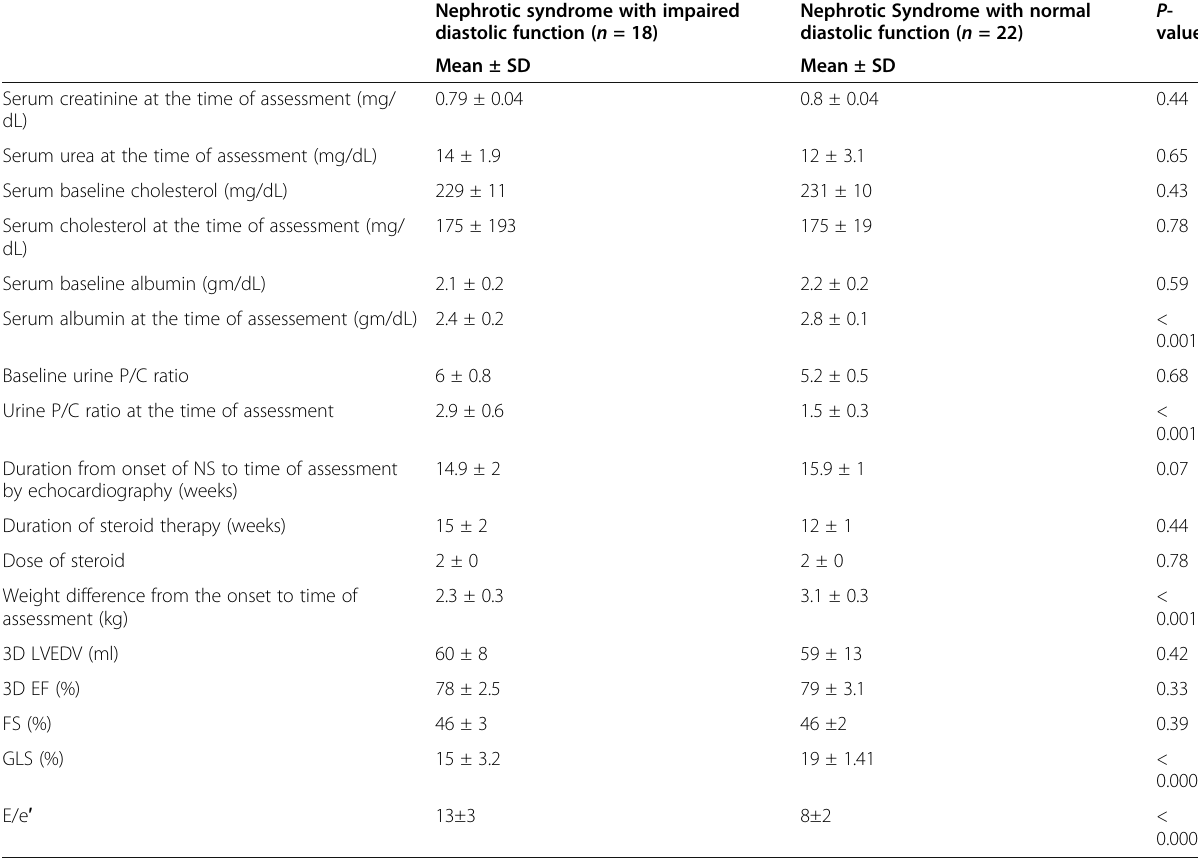
Table 4 Duration of nephrotic syndrome, steroid therapy, laboratory, and echocardiographic data in cases with diastolic dysfunction dysfunction vs. cases without